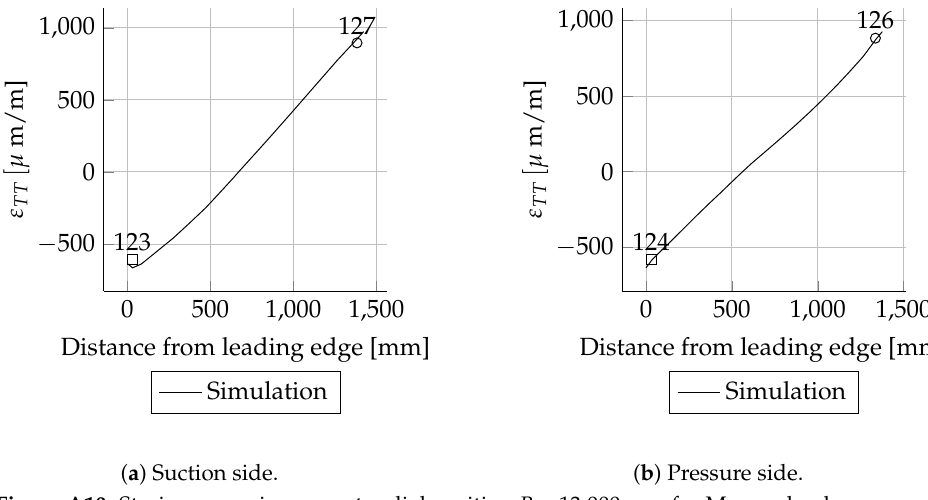
Figure A10. Strain comparison ε LL at radial position R = 13,000 mm for Mxmax load case.